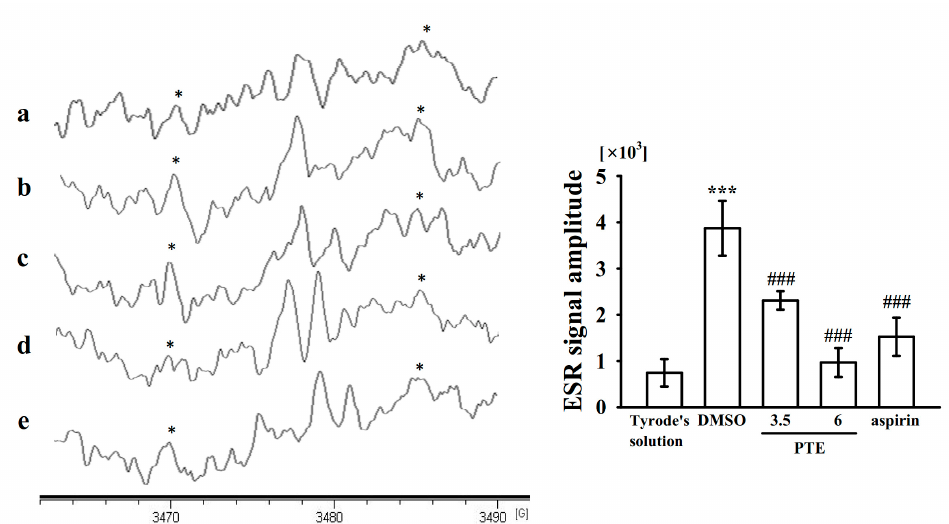
Figure 6. Activity of pterostilbene (PTE) on hydroxyl radical formation in human platelets. Washed platelets were incubated with ( a ) Tyrode’s solution only (resting group) or preincubated with ( b ) 0.1% DMSO, PTE ( c , 3.5 µ M; d , 6 µ M), ( e ) aspirin (100 µ M) followed by the addition of collagen (1 µ g/mL) to trigger hydroxyl radical (*) formation. Data are presented as the mean ± standard deviation ( n = 4). *** p < 0.001, compared with the Tyrode’s solution only (resting group); ### p < 0.001, compared with the 0.1% DMSO-treated group.